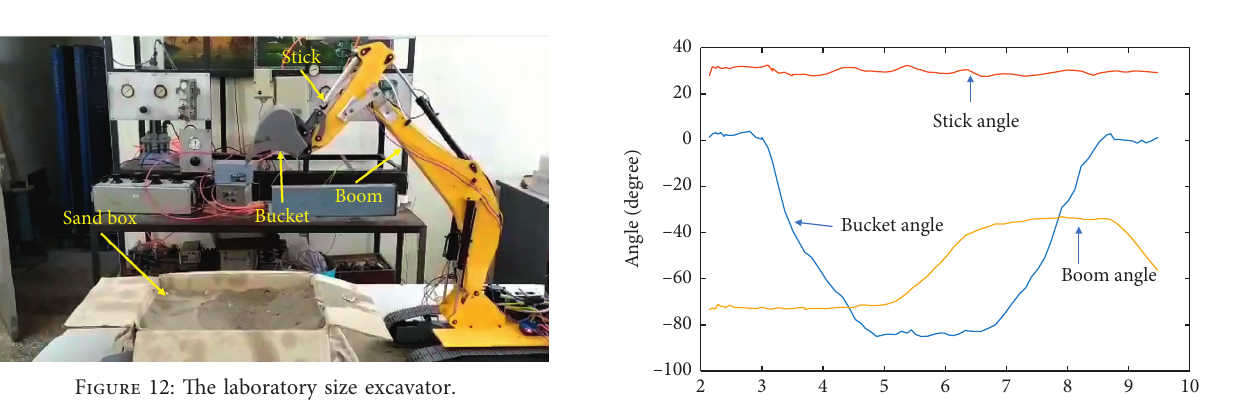
Figure 11: Shape of pile after 10 th and 20 th periods.